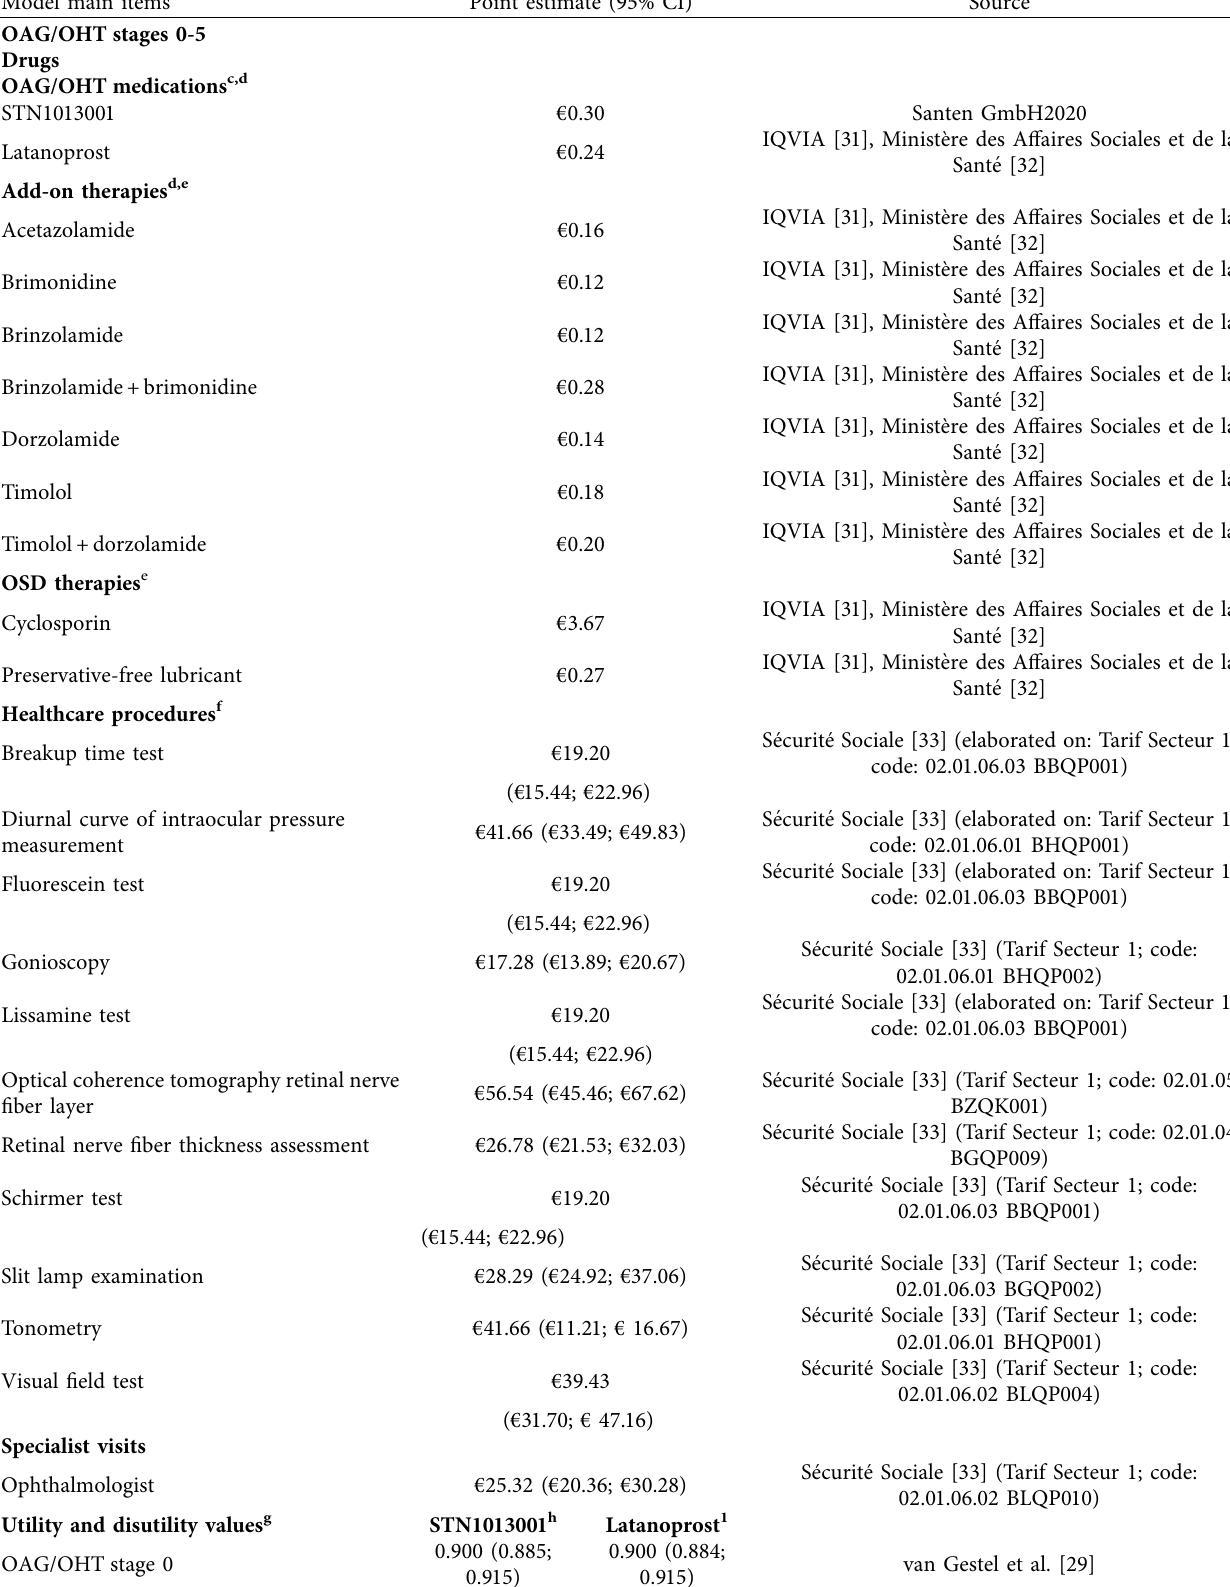
Table 1: Base case analysis–methods–unit cost for healthcare resources, utility, and disutility values (95% CI) a,b (costs in €